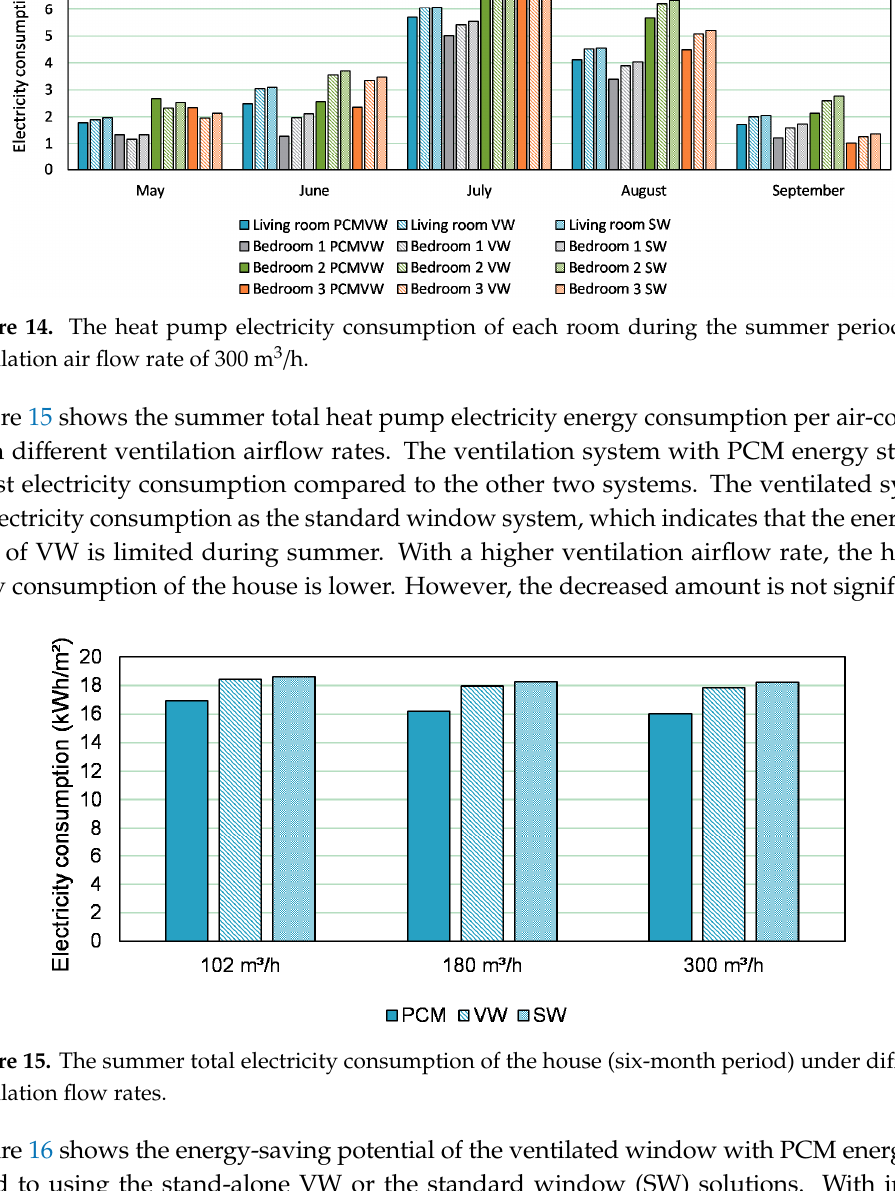
Figure 13. The heat pump electricity consumption of each room during the summer period at a ventilation airflow rate of 180 m 3 /h.